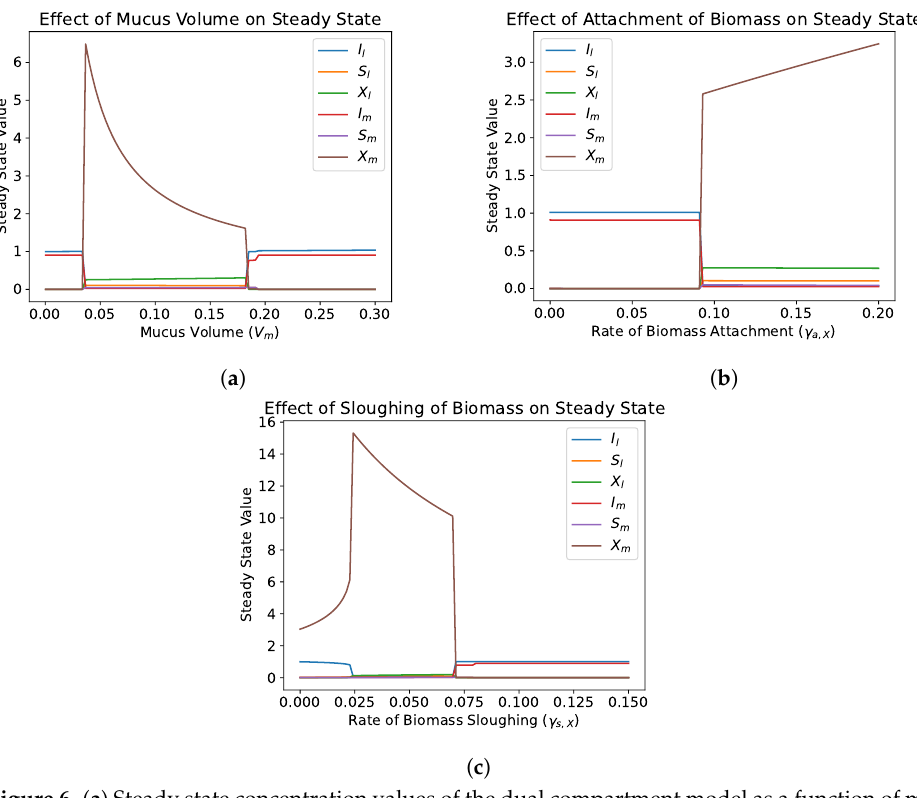
Figure 6. ( a ) Steady state concentration values of the dual compartment model as a function of mucus volume ( V m ). The total reactor volume was held constant ( V m + V l = 1.0). ( b ) Steady state values of the dual compartment model as a function of the rate of biomass attachment from the lumen to mucus ( γ a , X ). ( c ) Steady state values of the dual compartment model as a function of the rate of biomass sloughing from the mucus to lumen ( γ s , X